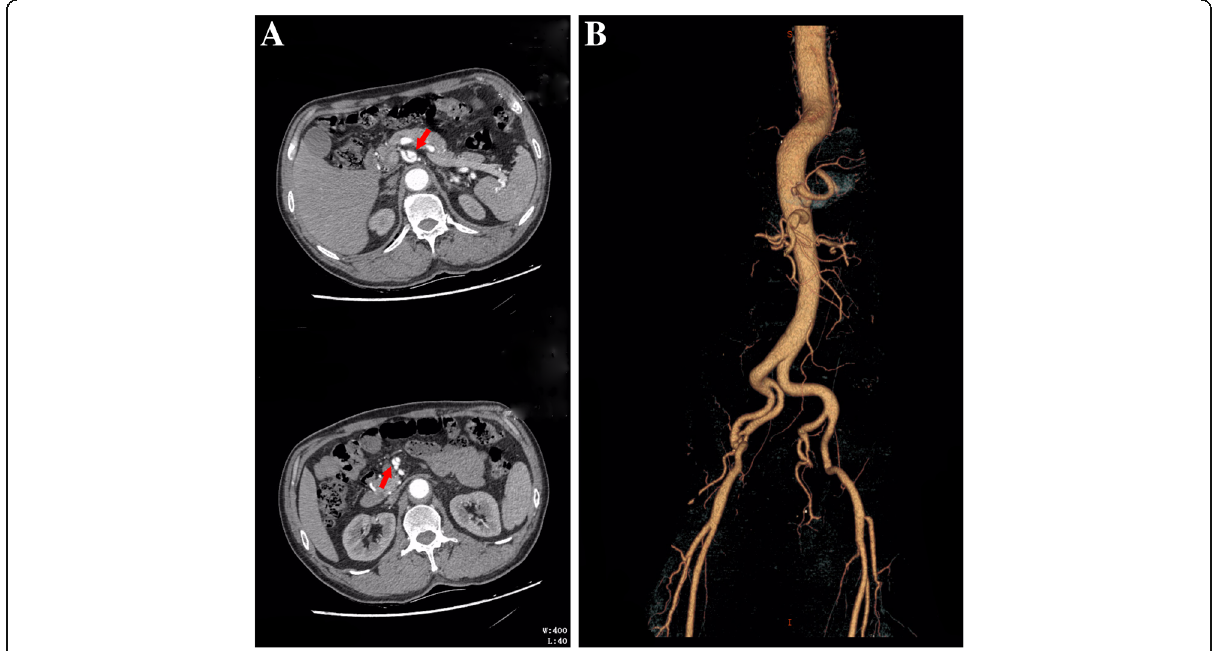
Fig. 1 Radiographic findings of the patient. a Multi-slice computed tomography shows abdominal aortic dissection with the celiac artery and the superior mesenteric artery (Red arrow) involved. b 3D-reconstructed computed tomography angiogram shows tortuosity of abdominal and iliac